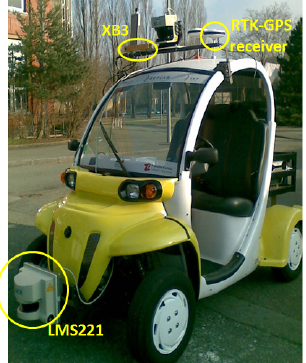
Figure 10. Equipped experimental platform.